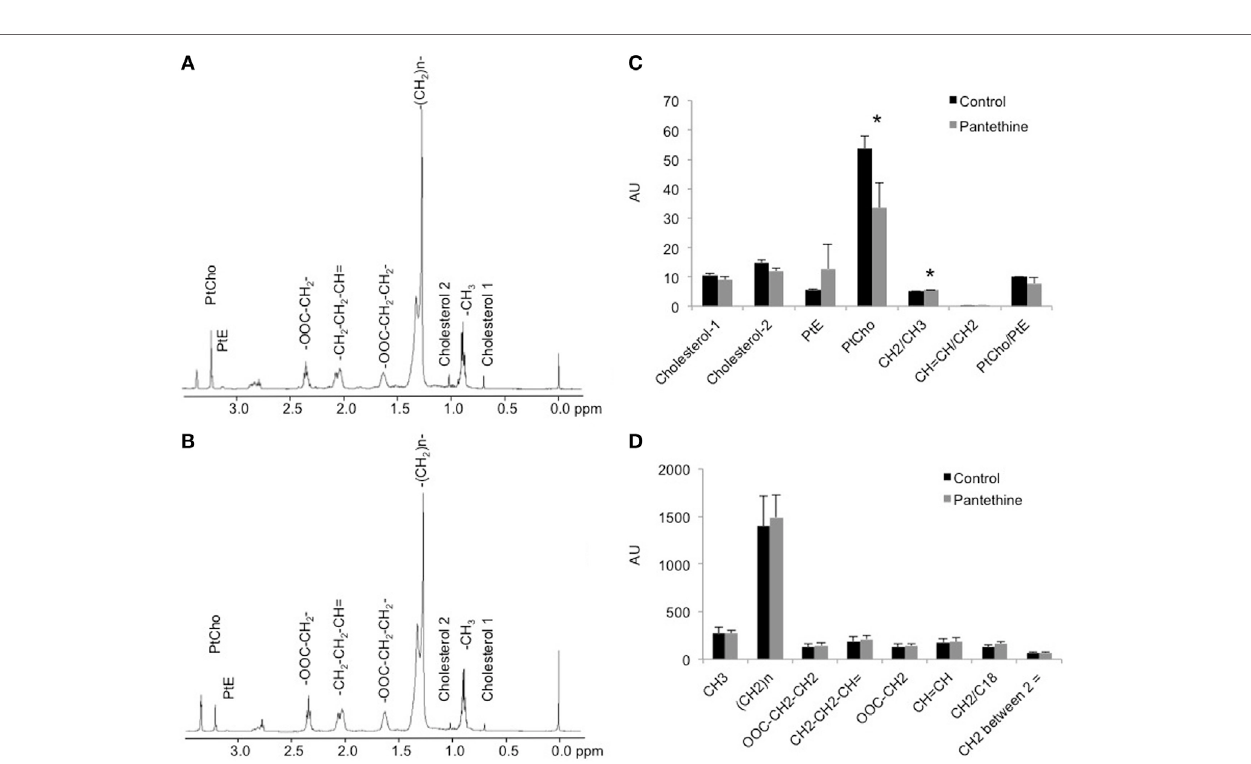
FigUre 6 | representative lipid phase 1 h Mr spectra from a control (a) and a treated (b) mice . (c,D) Lipid quantification in arbitrary unit (AU) from control and treated tumor extracts ( n = 5; * P <